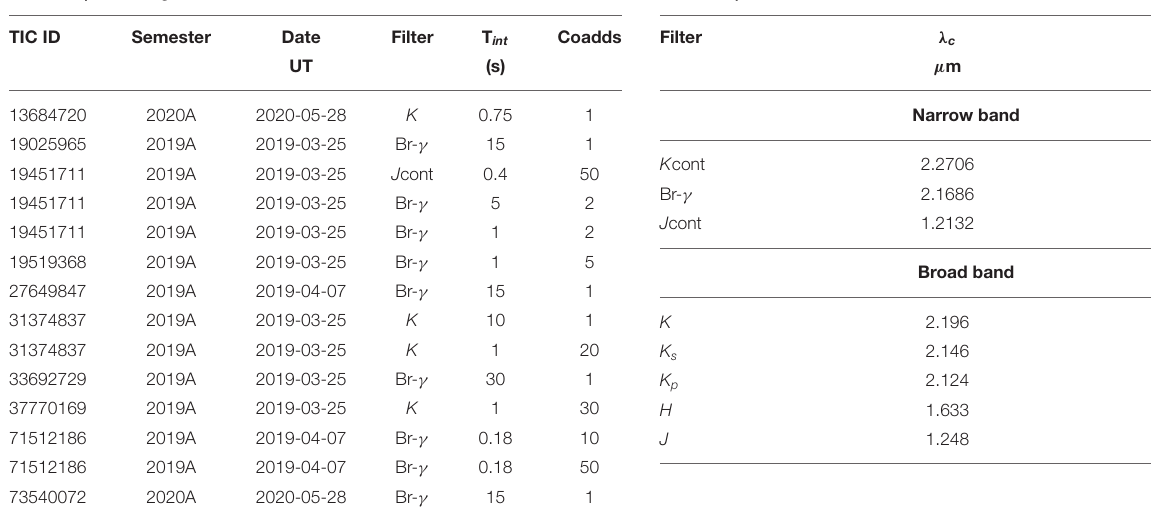
TABLE 3 | TESS targets and observation details a . TABLE 4 | NIRC2 filters